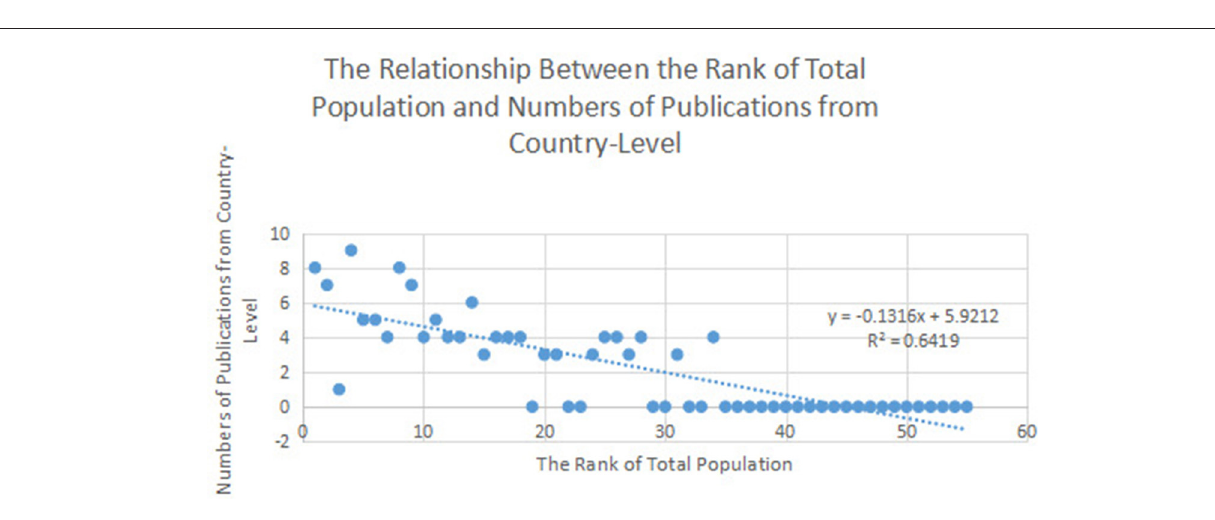
Hazak, Miao, Nu, Uygur, and Zhuang groups) had results for all four